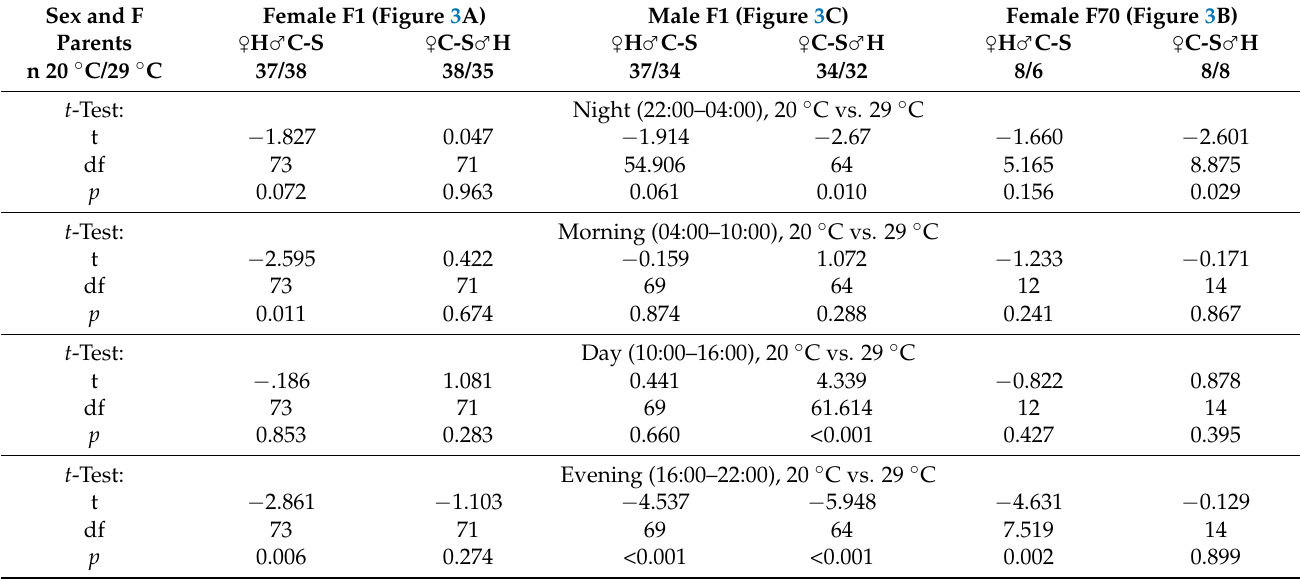
Table 3. Amount of sleep in four 6-h time intervals of the 24-h cycle: effect of temperature. Sex and